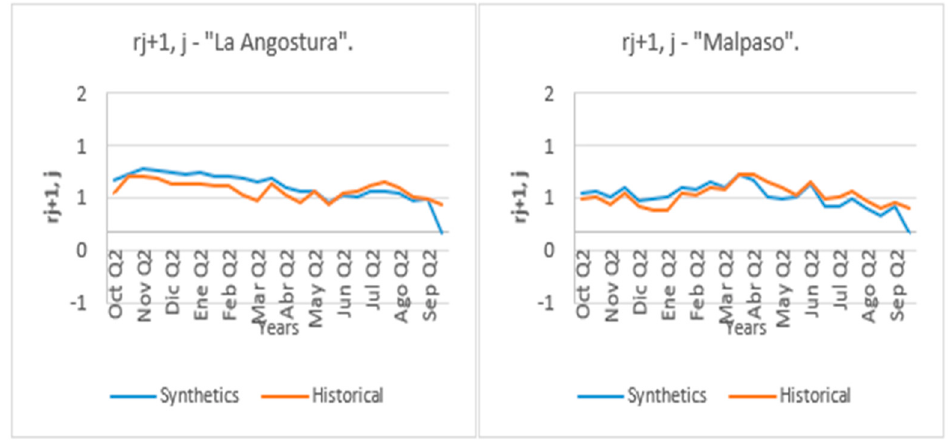
Figure 7. Comparison of the autocorrelation coefficient and average of the 10 synthetic series vs. historical series of La Angostura and Malpaso Dams.